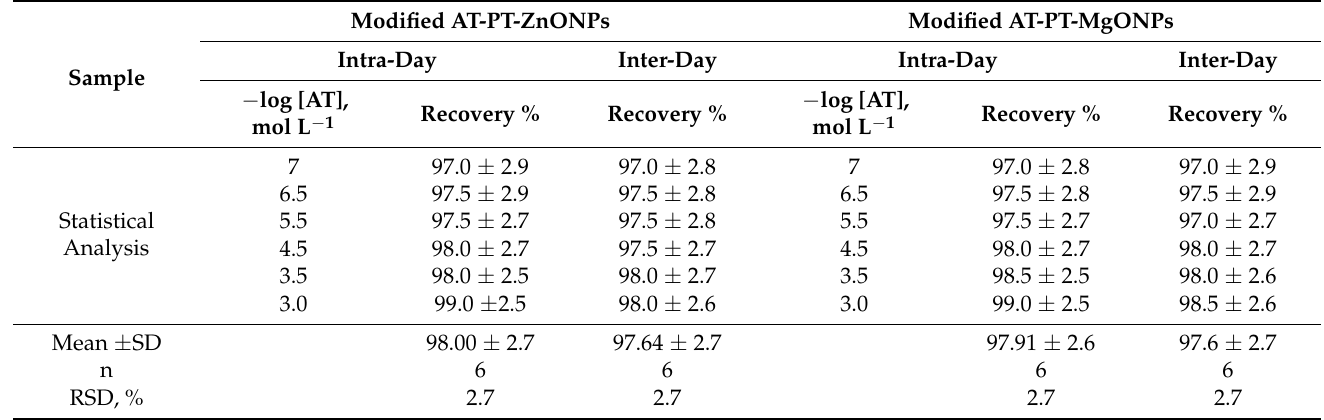
Table 4. The intermediate precision of the design of the AT-PT-ZnO and AT-PT-MgO nanocompos- ite sensors.